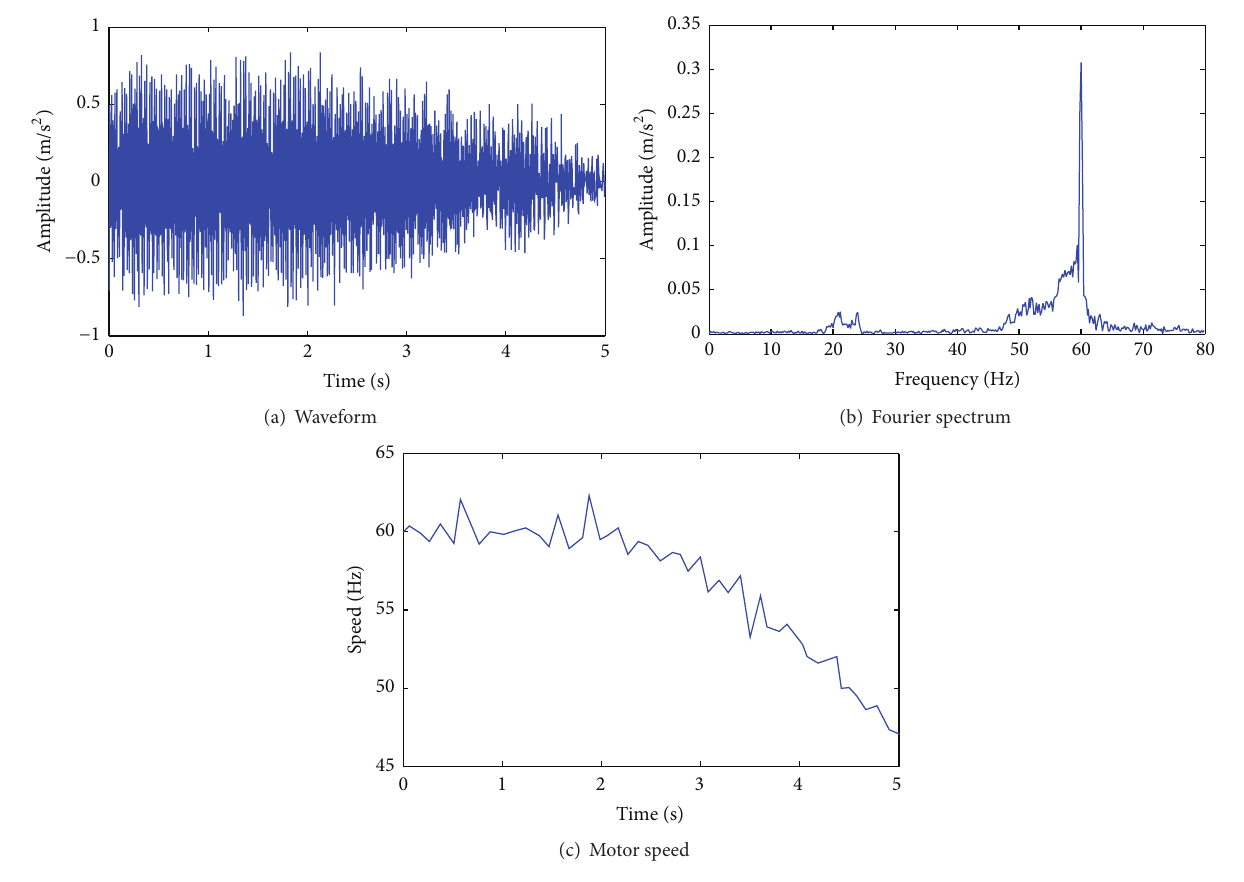
Figure 9: Chipped sun gear